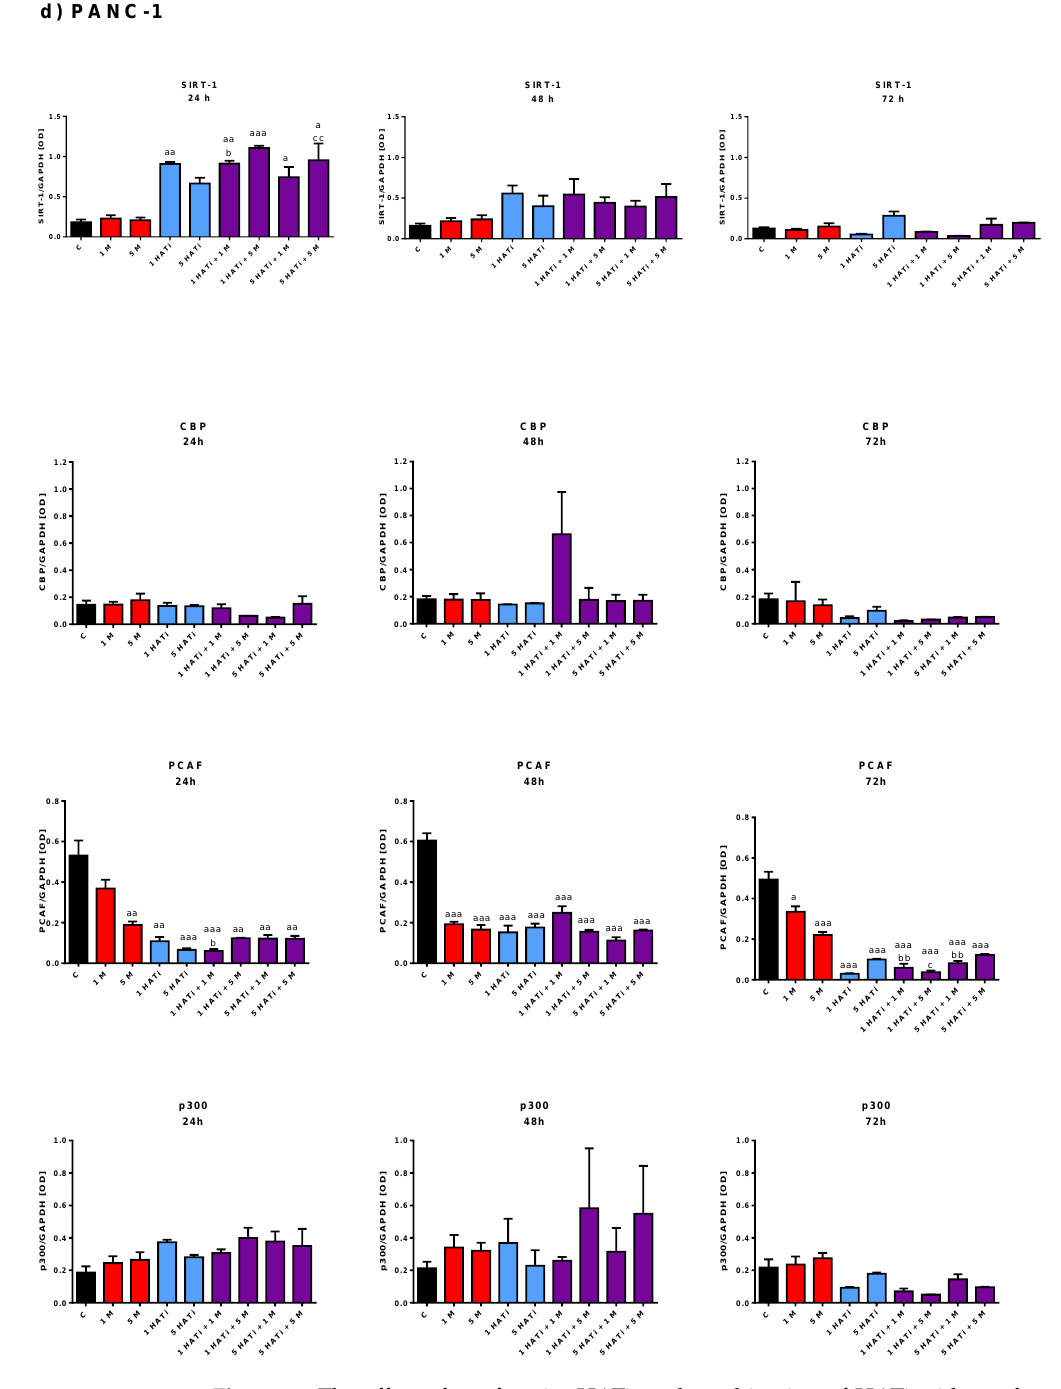
Figure 5. The effect of metformin, HATi, and combination of HATi with metformin on protein expression of HDAC (SIRT-1) and HATs (PCAF; p300; and CBP) in 1.2B4 ( a , b ) and PANC-1 ( c , d ) cells. Protein expression in 1.2B4 (( a ) representative blots and ( b ) quantitative graphs) and PANC-1 (( c ) representative blots and ( d ) quantitative graphs) cells was evaluated by Western blotting method. The cells were treated with metformin (1 and 5 mM; red bars), HATi (1 and 5 µM; blue bars), and combina- tion of HATi (1 and 5 µ M) with metformin (1 and 5 mM; violet bars) for 24, 48, and 72 h. The results are expressed as a percentage of optical density (OD) over the background ratio of target protein expression to GAPDH. Data are presented as OD means ± SEM. a p < 0.05; aa p < 0.01; aaa p < 0.001 vs. C; b p < 0.05; bb p < 0.01; bbb p < 0.001 vs. 1 M; c p < 0.05; cc p < 0.01; ccc p < 0.001 vs. 5 M; ddd p < 0.001 vs. 1 HATi; eee p < 0.001 vs. 5 HATi; ff p < 0.01; fff p < 0.001 vs. 1 HATi + 1 M; g p < 0.05; gg p < 0.01; hh p <